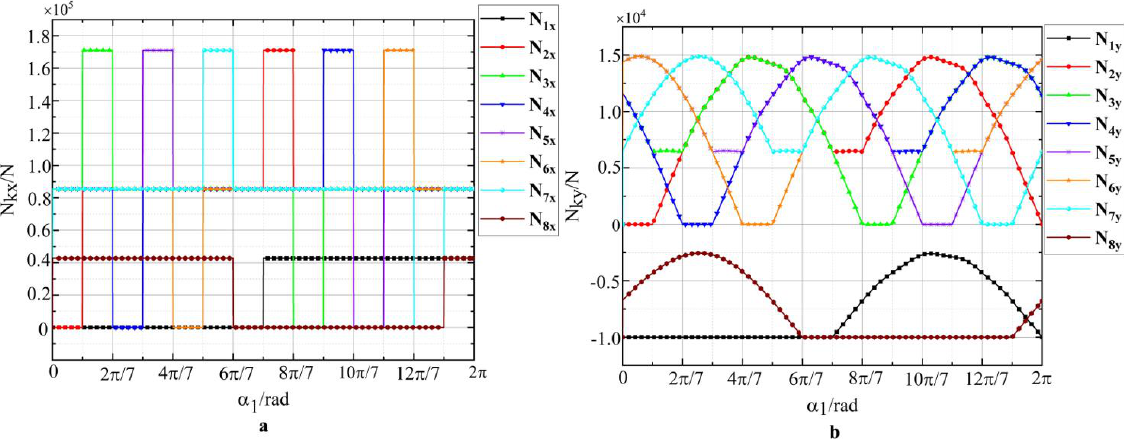
Figure 10. ( a ) Diagram of the x-direction support reaction force N kx of each support seat of the crankshaft, ( b ) Diagram of the y-direction support reaction force N ky of each support seat of the crankshaft.